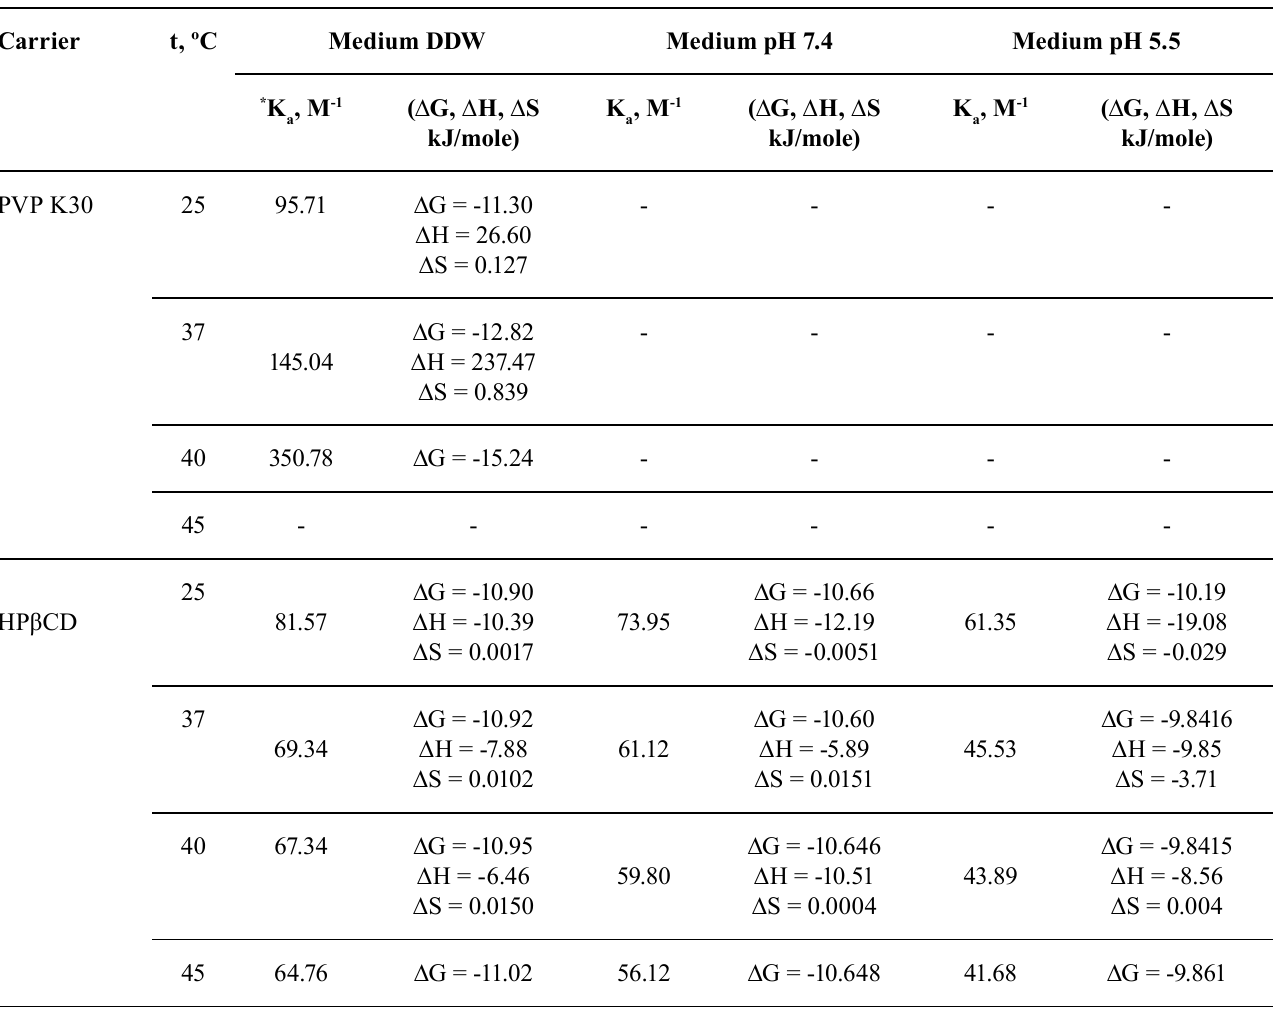
TABLE III – Thermodynamic parameters and binding constants of Met base at different media and at different temperatures